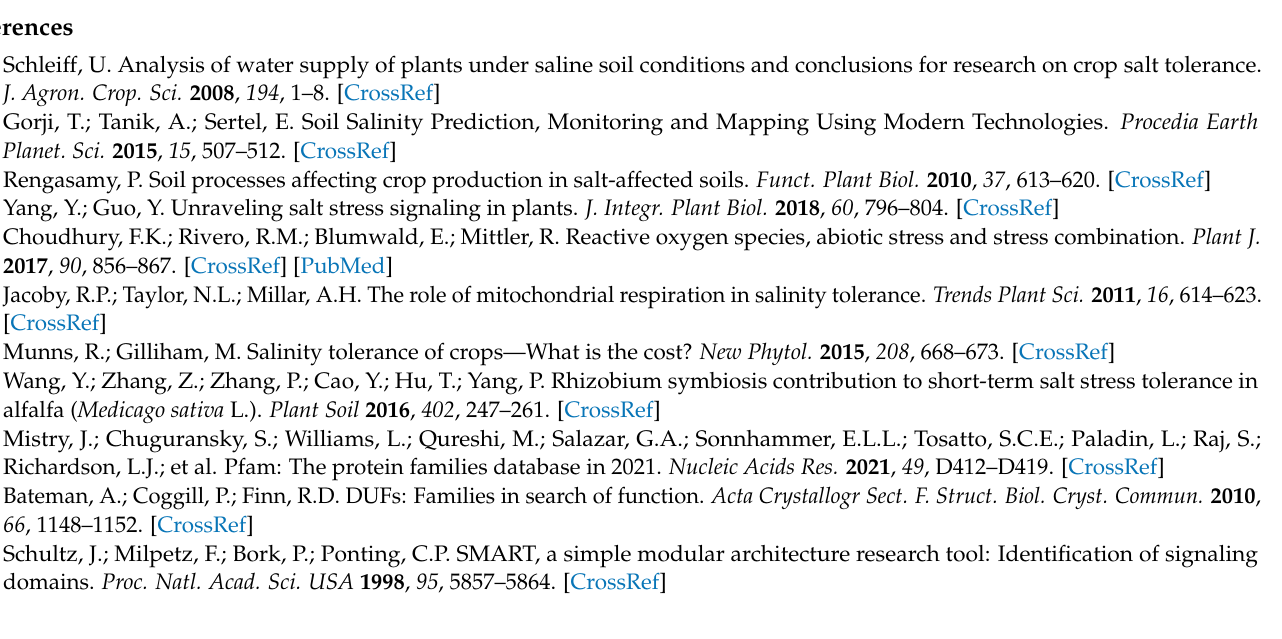
cotton. Table S4: The Ka and Ks values for homologous gene pairs in cotton. Table S5: The information of species and their genome used for identification of DUF4228 proteins in this study. Table S6: List of primers used for qRT-PCR analysis and virus-induced gene silencing (VIGS)